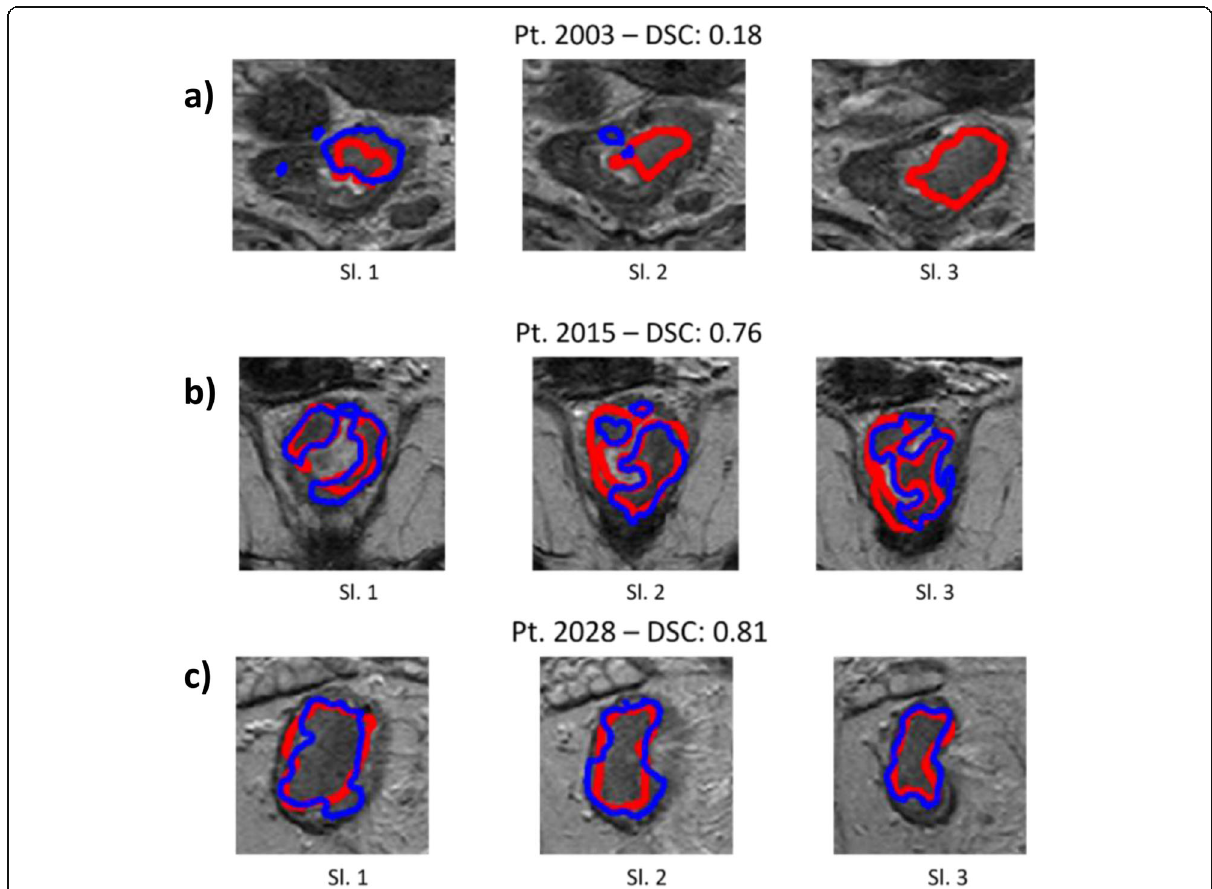
Fig. 4 Examples of three patients segmented by internally developed fully convolutional network model (blue line) and the radiologists (red line). Pt. 2003 with DSC of 0.18 ( a ) and Pt. 2015 with DSC of 0.76 ( b ) were wrongly classified by both manual and automatic systems, while Pt. 2028 with DSC of 0.81 ( c ) was wrongly classified only by the automatic model. DSC Dice similarity coefficient, Pt Patient, Sl. Slice